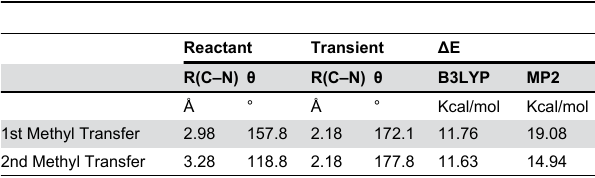
2 Transition State * N